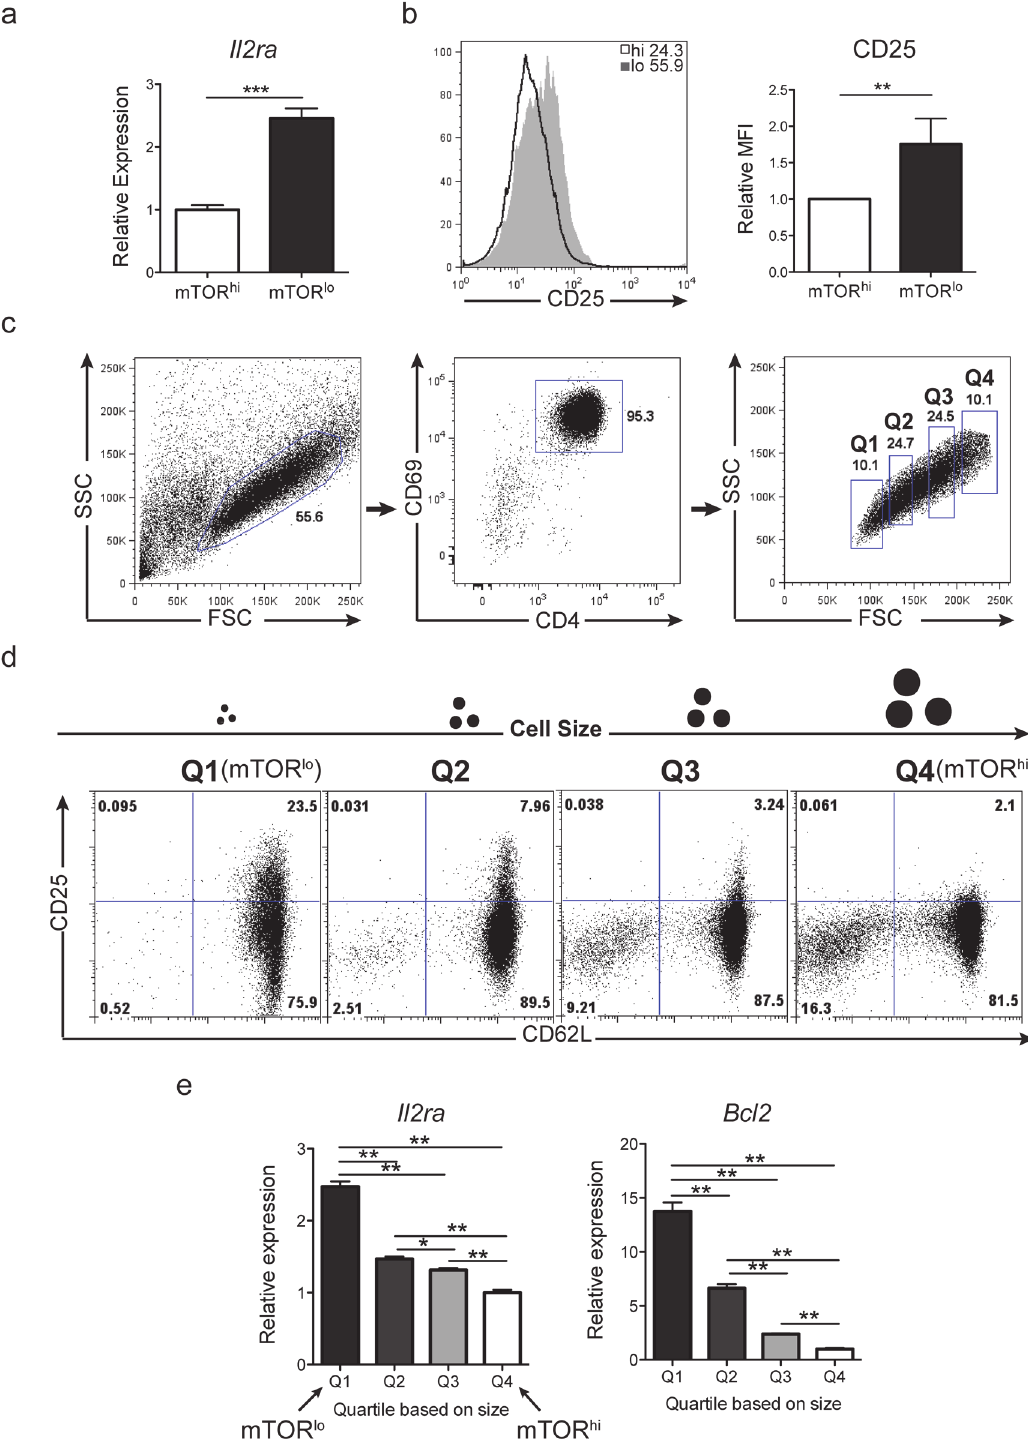
Fig 4. Divergent fates of activated CD4+ T cells can be tracked with gradients of cellular size following activation. a-b) Splenocytes from 5c.c7 Rag – / — mice were stimulated with 0.5ug/ml PCC peptide for 24hrs and then sorted into CD4+CD69+ populations with FSC/SSC “ big ” mTOR hi or FSC/SSC “ small ” mTOR lo profiles. Cells were cultured in media supplemented with IL-2 for 3 days. a) 3 days after sort, mTOR lo cells express higher mRNA transcript, and b) surface protein expression of CD25 than sorted mTOR hi cells. The bar graph to the right depicts the fold increase in CD25 MFI expression in mTOR lo cells compared to mTOR hi cells from 6 replicate experiments, with expression of mTOR hi cells set to a value of 1. Error bars